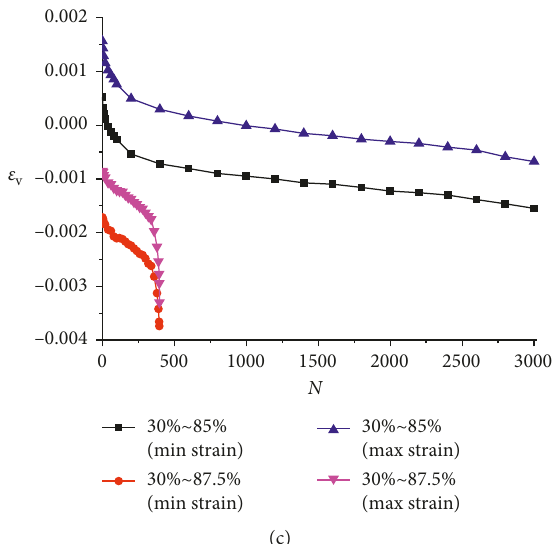
Figure 6: Maximum and minimum strain evolution for sample SA. 6 at different cyclic loading levels as a function of cycle number: (a) axial strain, (b) circumferential strain, and (c) volumetric